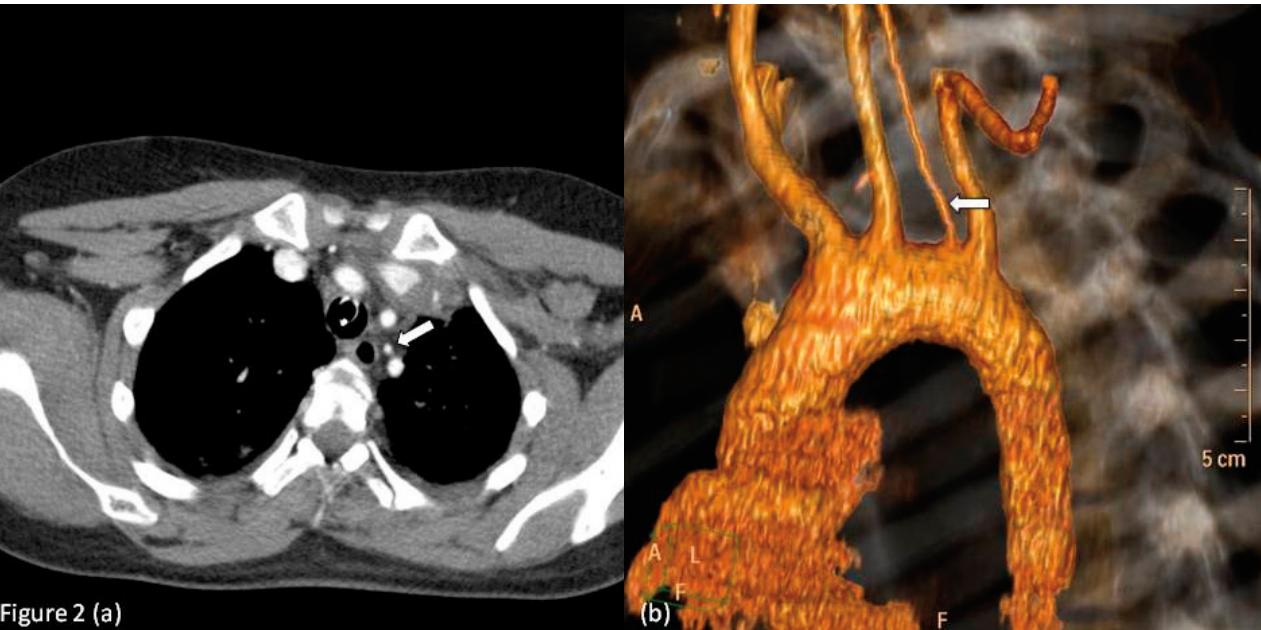
Fig. 2. (a) CT angiogram and (b) 3D reconstruction. Left vertebral artery (white arrows) arising from the aortic arch between the left carotid and the left subclavian arteries was demonstrated in 4 patients.